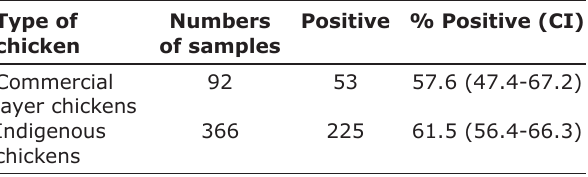
Table-1: Seroprevalence of antibodies for CAstV in chickens in Grenada, West